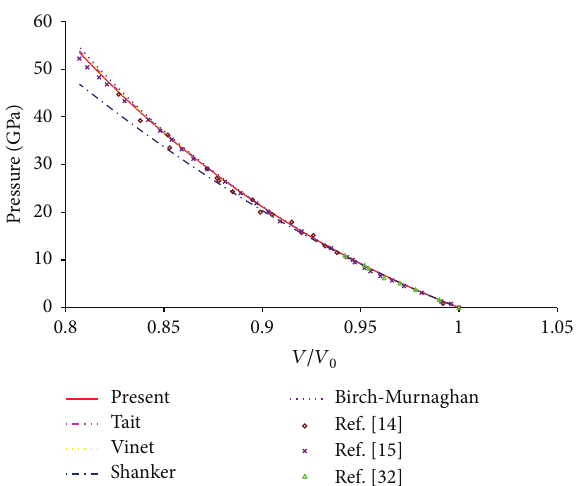
Figure 1: Compression behavior of MgO using different EOSs along with the experimental results.